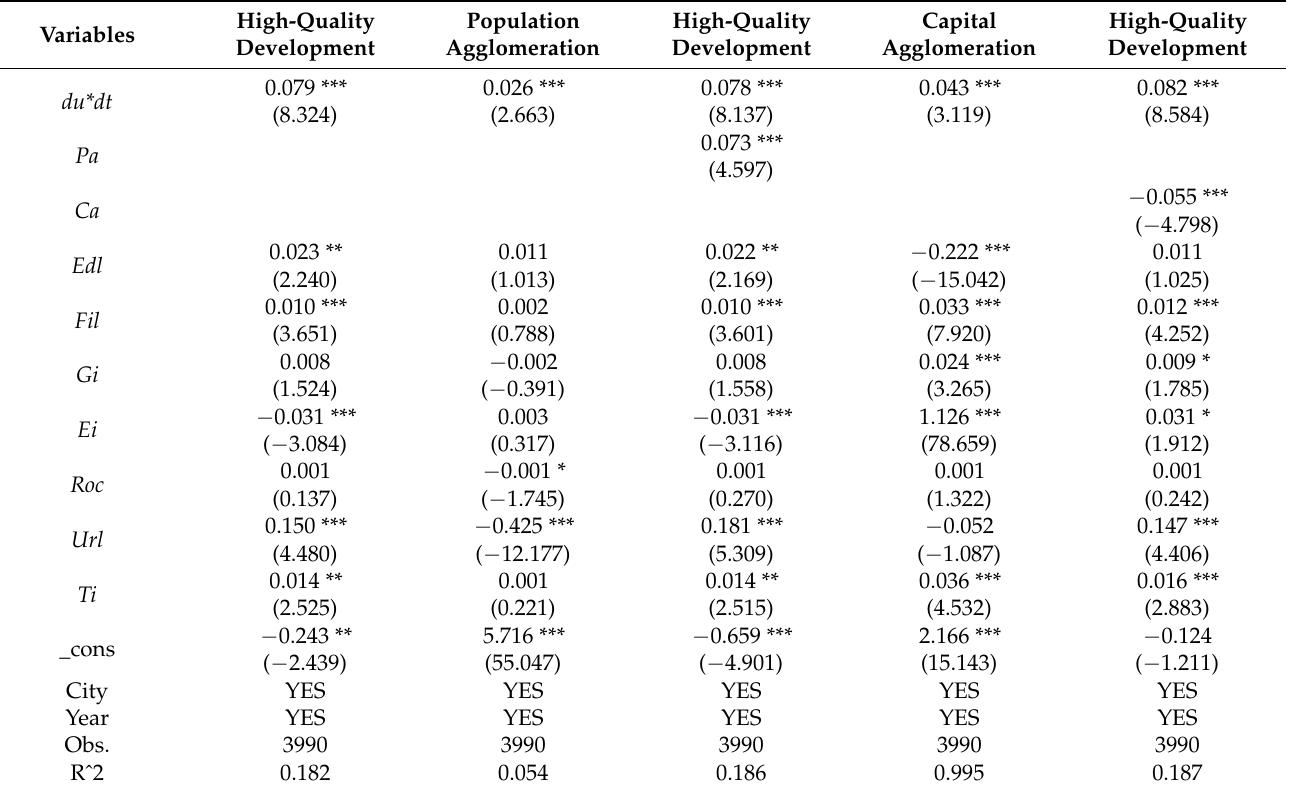
Table 5. Results of the test for mechanism